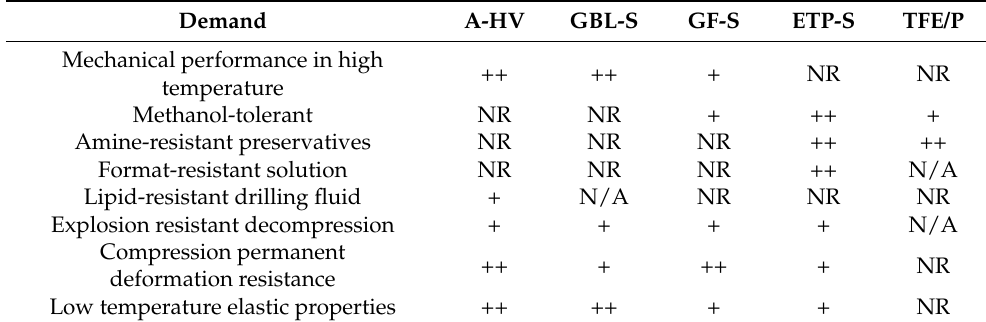
Table 8. Selection Guide for Fluorine Elastomer.